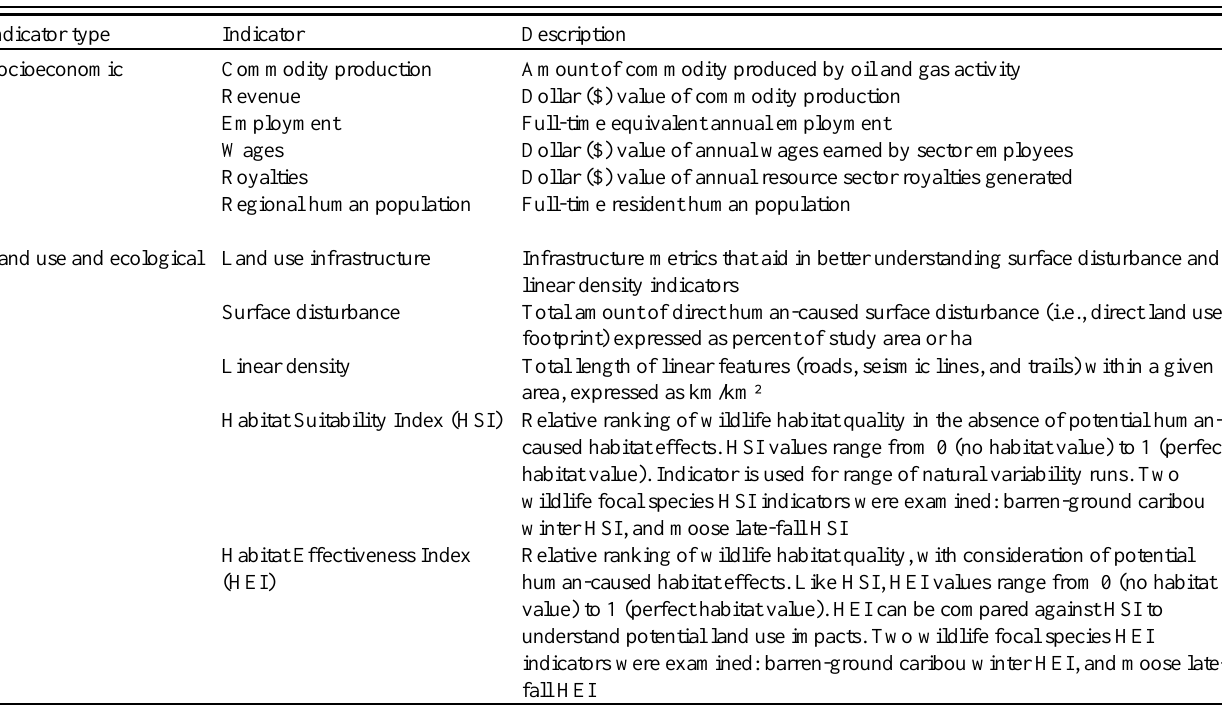
Table 3 . Eagle Plain oil and gas scenario